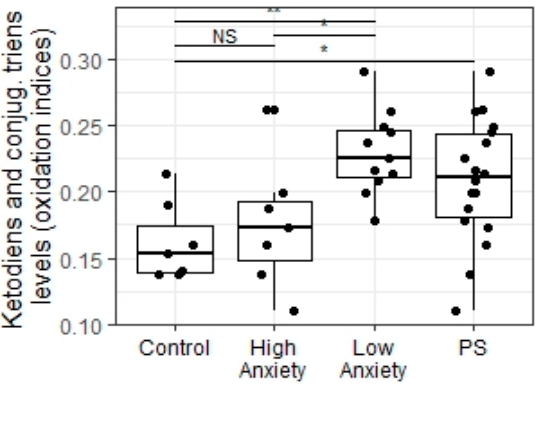
Figure 8. Ketodiens and conjugated triens levels (oxidation indices) in the hippocampus of PSS rats segregated into high- and low-anxiety groups according to AI as determined by performance in the EPM. Differences in ketodiens and conjugated triens concentrations among groups are shown as boxplots with dots representing individual data values and medians shown by horizontal lines. The boxes include the central 50% of the data, i.e., from the 25th to the 75th percentile. The whiskers include the data contained within 1.5 times the interquartile range. NS = p > 0.05; * p < 0.05; ** p < 0.01. p values were determined in non-parametric